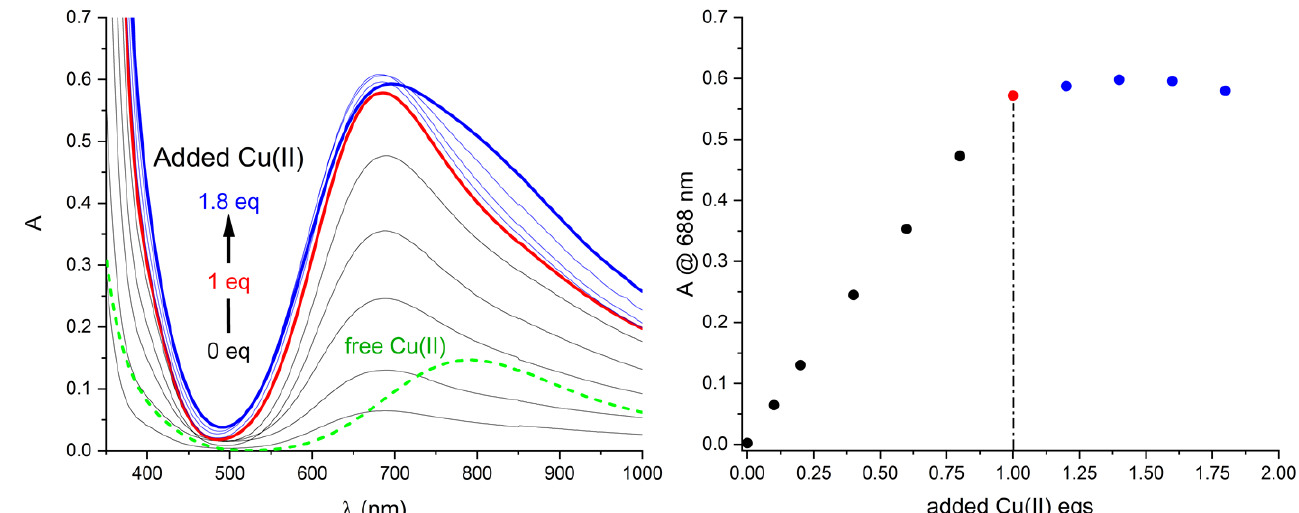
Figure 3. Left: titration of L ([L] = 1.8 mM) with Cu(II) equivalents. Right: behaviors of the absorption maximum. Complex band raises steadily until 1 eq of Cu(II) is added, then spectral changes are associated with free Cu(II) in solution (green-dashed spectrum: Cu(II) 1.8 mM in DMF).